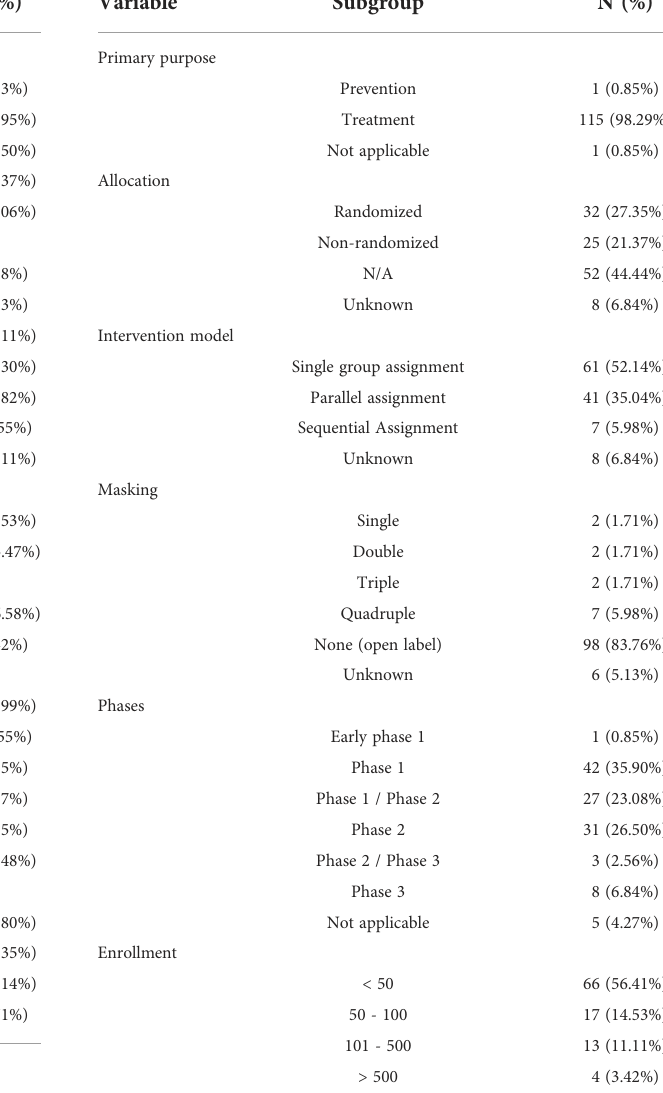
TABLE 1 Characteristics of all included trials (n = 117). TABLE 2 Study design elements of included trials (n =